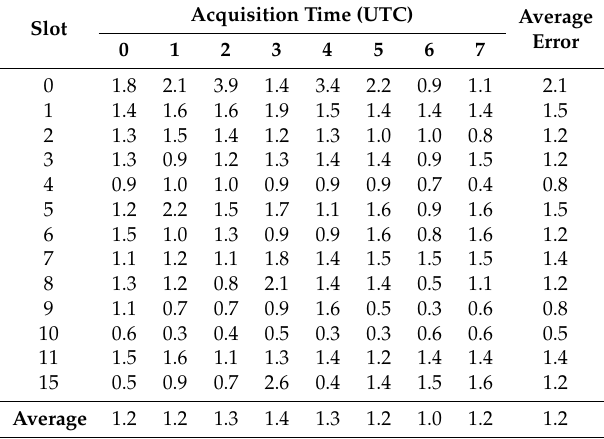
Table 7. RMSE of geometric correction with frequency matching (excludes outliers) (in km).